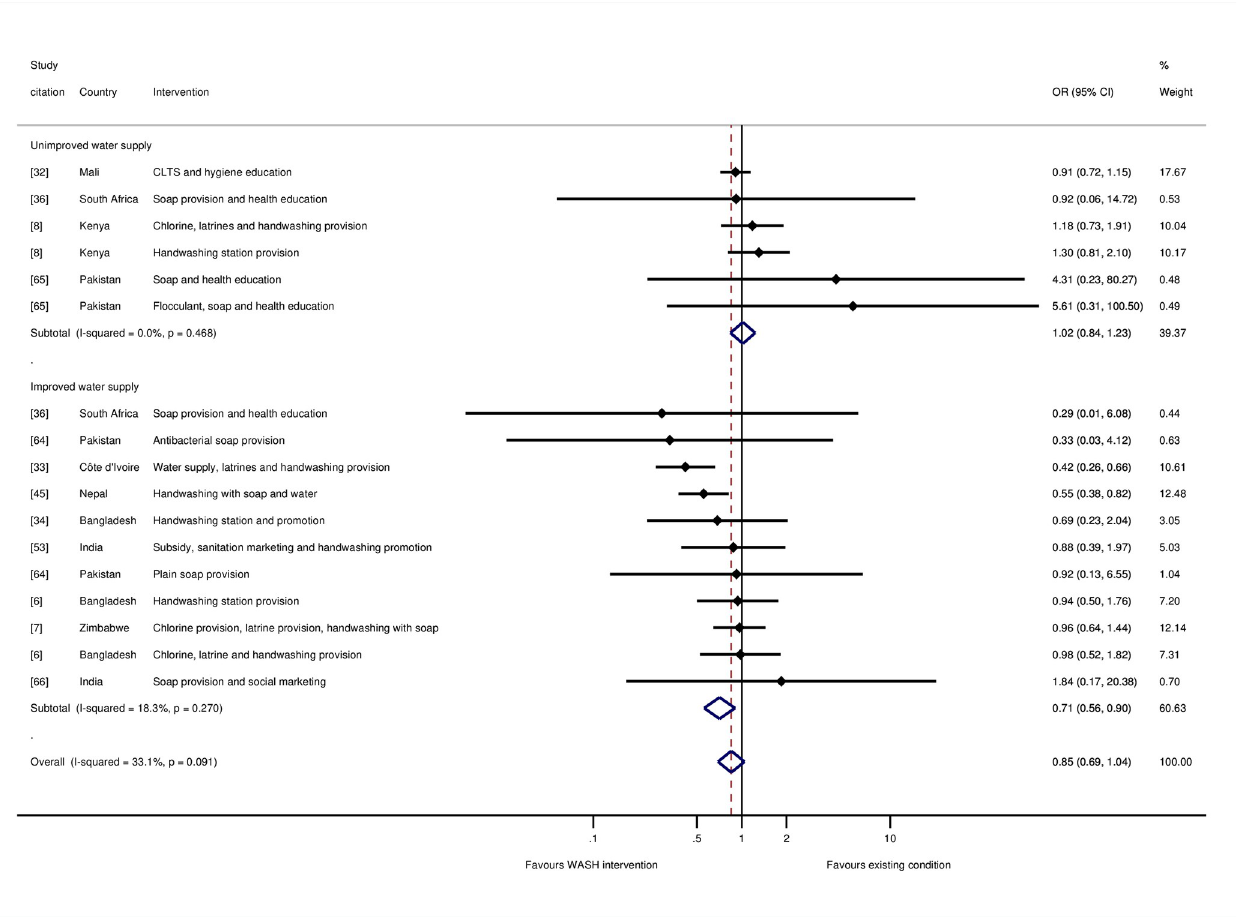
Fig 7. Effects on all-cause mortality in childhood of hygiene